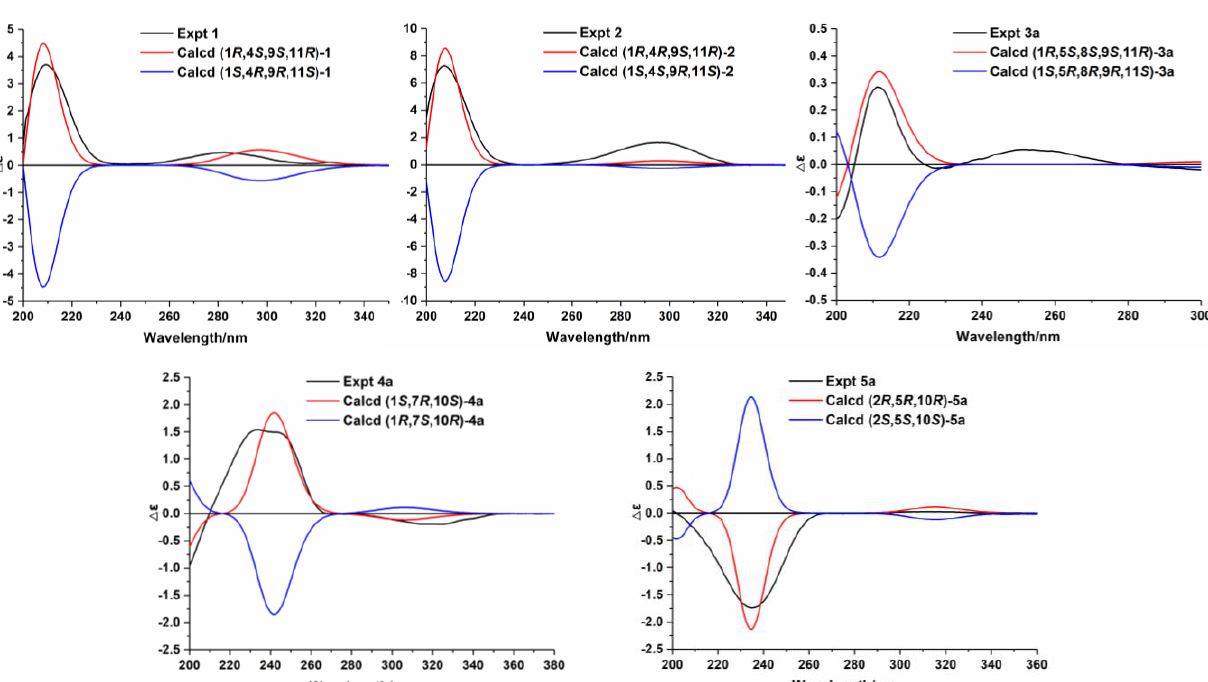
Figure 4. Experimental and calculated ECD spectra of compounds 1 – 2 and 3a – 5a . Based on the HR-ESI-MS data of compound 2 , its chemical formula is similar to that of compound 1 . The 1 H, 13 C, and 2D NMR spectra of compounds 2 and 1 showed that the planar structures of these two compounds are identical. Further analysis revealed that compound 2 was a C-4 epimer of compound 1 based on the NOESY correlations of H 2 -14/H-1, H-1/H 3 -12, and H-9/H 3 -15 (Figure 3) . Moreover, ECD calculations showed that the absolute configuration of compound 2 is 1 R ,4 R ,9 S ,11 R (Figure 4). Therefore, compound 2 was identified as (+)-(1 R ,4 R ,9 S ,11 R )-caryophyll-8(13)-en-14-ol-5-one. Compound 3 has a molecular formula of C 21 H 34 O 7 , as determined by the HR-ESI-MS. The 1 H, 13 C, and DEPT NMR data of compound 3 suggested that it is also a caryophyllane-type sesquiterpenoid. The signals for an anomeric proton [ δ H 4.24 (d, J = 7.8 Hz)] and an